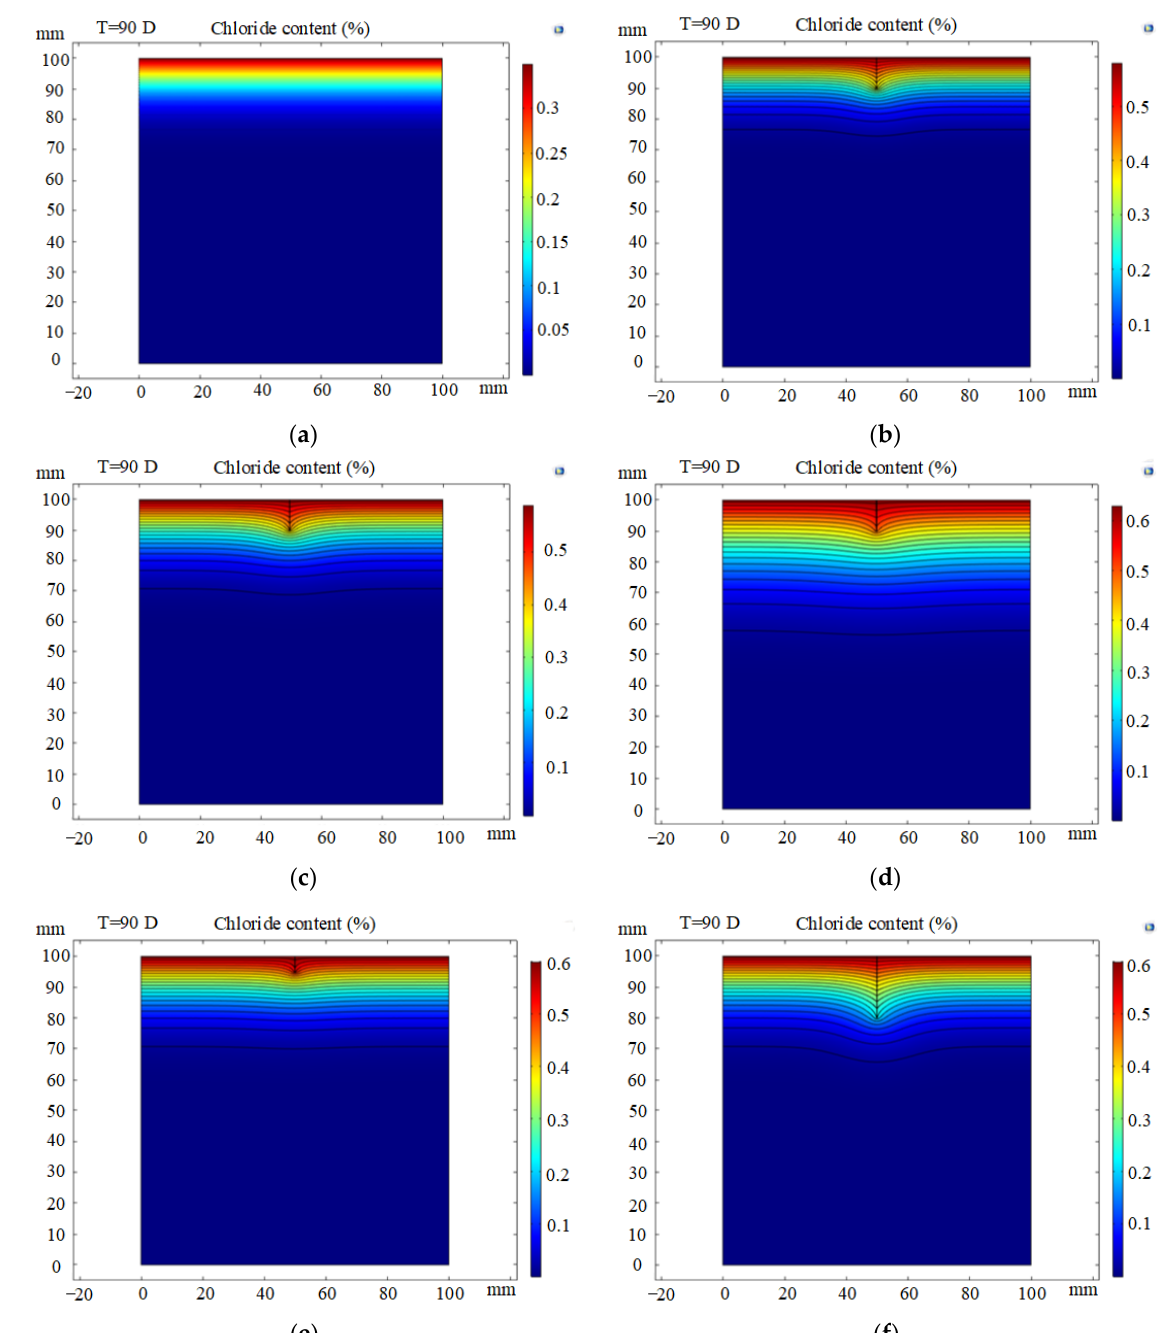
Figure 9. Simulated chloride distribution contours in cracked concrete lining: ( a ) crack width = 0 mm, crack depth = 0 mm (i.e., sound concrete); ( b ) crack width = 0.05 mm, crack depth = 10 mm; ( c ) crack width = 0.1 mm, crack depth = 10 mm; ( d ) crack width = 0.2 mm, crack depth = 10 mm; ( e ) crack width = 0.1 mm, crack depth = 5 mm; ( f ) crack width = 0.1 mm, crack depth = 20 mm.